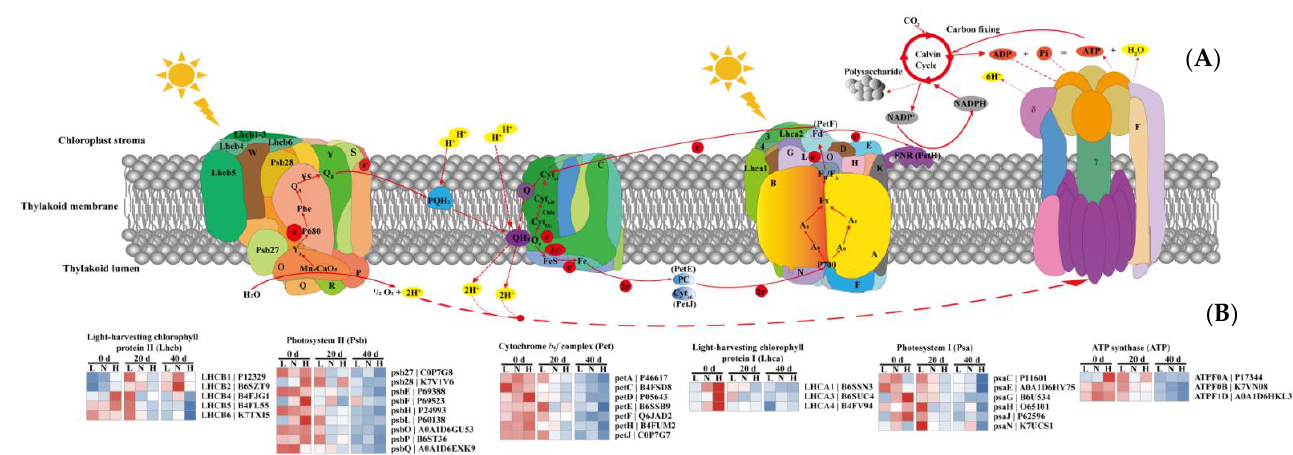
Figure 8. Light-induced changes in the levels of differentially abundant proteins (DAPs) in the photosynthetic apparatus. ( A ) Schematic representation of photosynthetic linear electron flow and proton translocation driven by protein complexes in the thylakoid membrane. ( B ) Levels of differentially abundant proteins (DAPs) in the photosynthetic apparatus. Core light-harvesting chlorophyll protein II and I are Lhcb 1-6 and Lhca 1-4, respectively. Core PSII subunits are Psb27, Psb28, PsbO, PsbP, PsbQ, PsbR, PsbS, PsbW, and PsbY. Core Cyt b 6 f subunits are PetC, PetE, PetF, PetH, and PetJ. Core PSI subunits are PsaD, PsaE, PsaF, PsaG, PsaH, PsaK, PsaL, PsaN, and PsaO. Core subunits related to ATP synthase are ATPF, ATP , and ATP . Colored scales of the Z score ( – log 10 p -value) are shown: proteins that accumulated at high levels are in red, and proteins with low accumulation levels are in blue. L, low density; N, normal density; H, high density; 0, 20, and 40 d, days after anthesis.